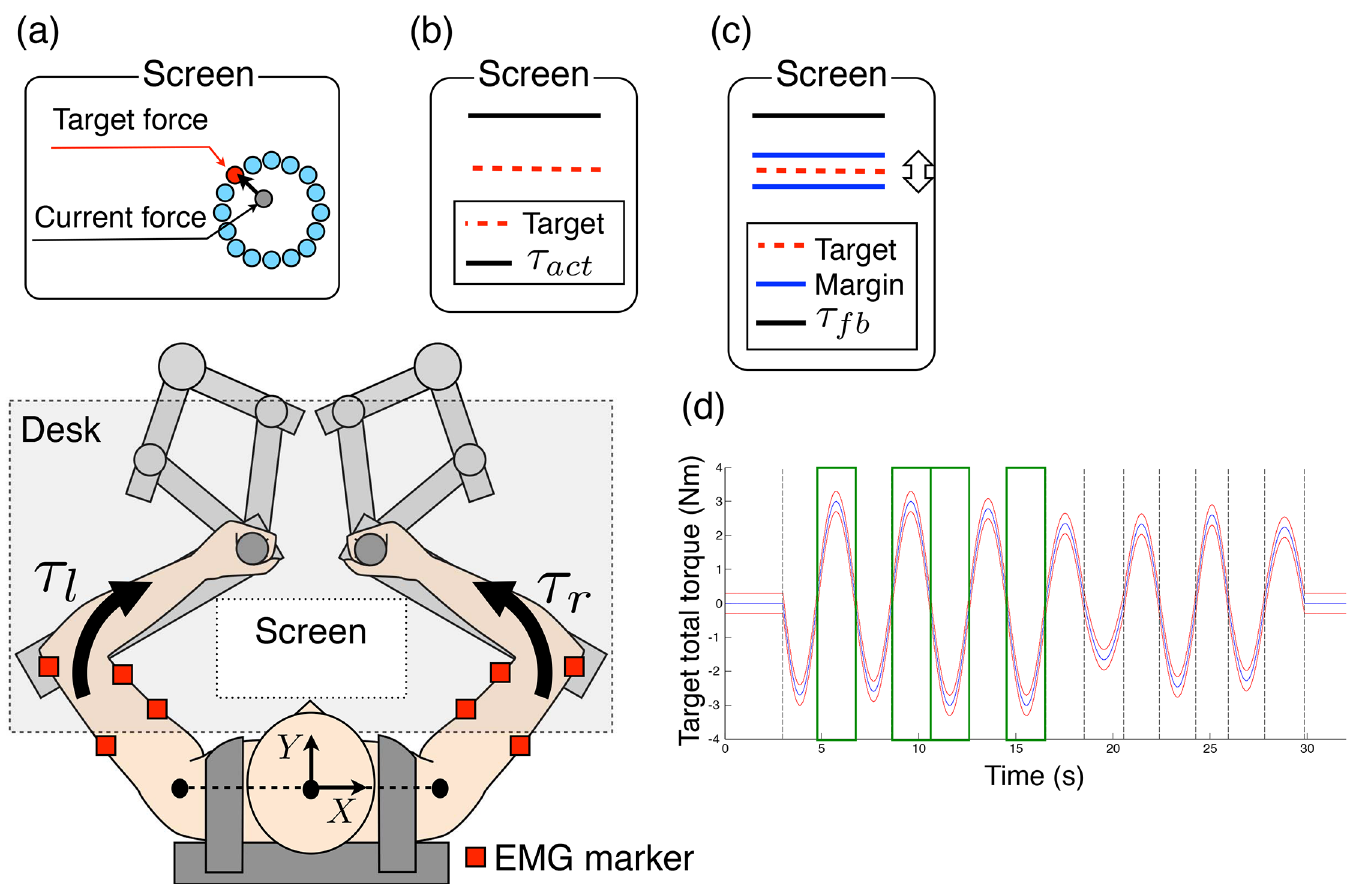
Fig 4. Schematic of the experimental set-up. Subjects were seated on a chair, wearing a seat-belt to fix their trunks, and had force sensors placed in their right and left hands. The red squares denote electrodes used to record the electromyogram data. The screen on the desk showed the information corresponding to the target hand force production task (a), the target total torque production task (b), and the tracking-ability learning task (c). (d) One example of a target trajectory of total elbow torque. The target trajectory consists of 14 half-sine waves. The four half-sine waves in the green boxes are standard half-sine waves (amplitude: ± 3 N (cid:2) m, period: 4 s), and the others are randomly generated half-sine waves (amplitude: mean ± 3 N (cid:2) m, standard deviation 1 N (cid:2) m, period: mean 4 s, standard deviation 0.4 s). The blue line indicates the target trajectory and the red lines indicate the ± 0.3 N (cid:2) m